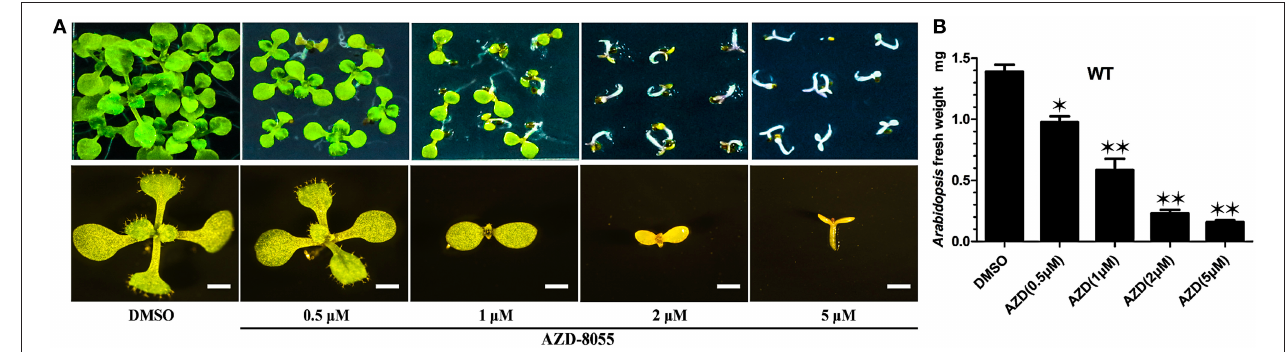
FIGURE 1 | AZD arrests early seedlings establishment in Arabidopsis . (A) Representative images of WT plants growing on ½ MS medium containing increasing concentrations of AZD for 10 days (upper panel). The lower panel shows enlarged images of the individual seedling in the upper panel. Bar = 1mm. (B) Fresh weight of WT seedlings growing on different AZD concentrations for 10 days. Each graph represents the average of 30 seedlings that were conducted in triplicate. Error bars indicate ± SD for triplicates. Asterisks denote Student’s t -test significant difference compared with DMSO ( * P < 0.05 ; ** P < 0.01 ).